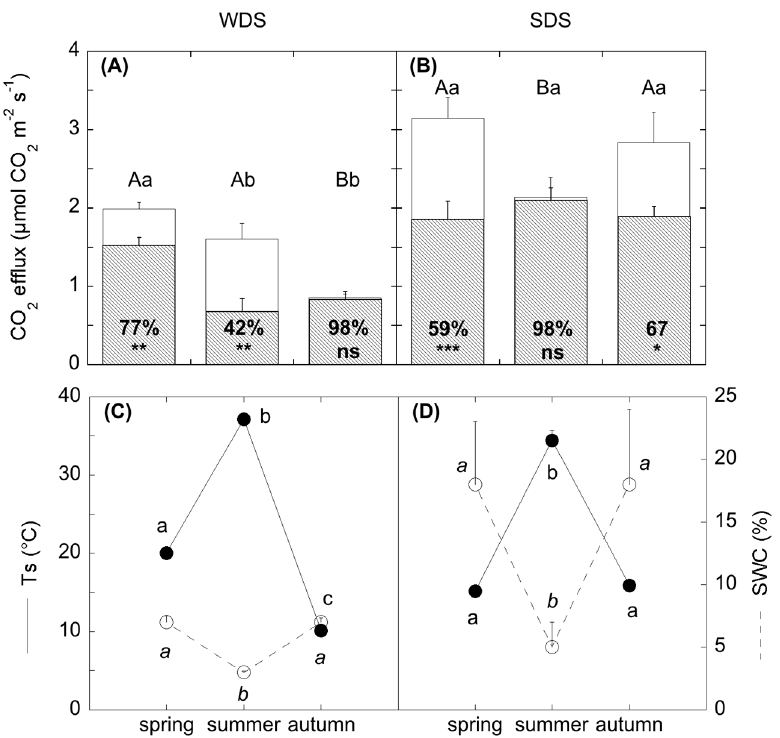
Figure 2. CO 2 efflux (±s.e., n = 10; bars, upper panels), soil water content (SWC ± s.e.; n = 10; lower panels; right y-axis) and soil temperature (Ts ± s.e., n = 10; lower panels; left y-axis; temperature is full circle with continuous line, soil water content is white circle with dashed line) in winter deciduous (WDS, left panels, A , C ) and summer deciduous (SDS, right panels, B , D ) sites. In panels ( A ) and ( B ), total (field measurements; white bars) and heterotrophic (laboratory measurements; strikethrough bars) CO 2 efflux are shown; percentage numbers are the contribution of the heterotrophic respiration to the total soil CO 2 efflux; ***, **, * indicate differences between total and heterotrophic respiration at p < 0.001, p < 0.01, p < 0.05, respectively. Capital and lowercase letters in panels ( A , B ) show significant seasonal variations ( p < 0.05) of total and heterotrophic CO 2 efflux, respectively. In panels ( C , D ) normal and italic lowercase letters indicate seasonal differences of soil temperature and soil water content, respectively.